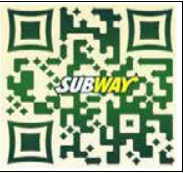
Figure 2: Third-generation QR Code (Demir et al., 2015: